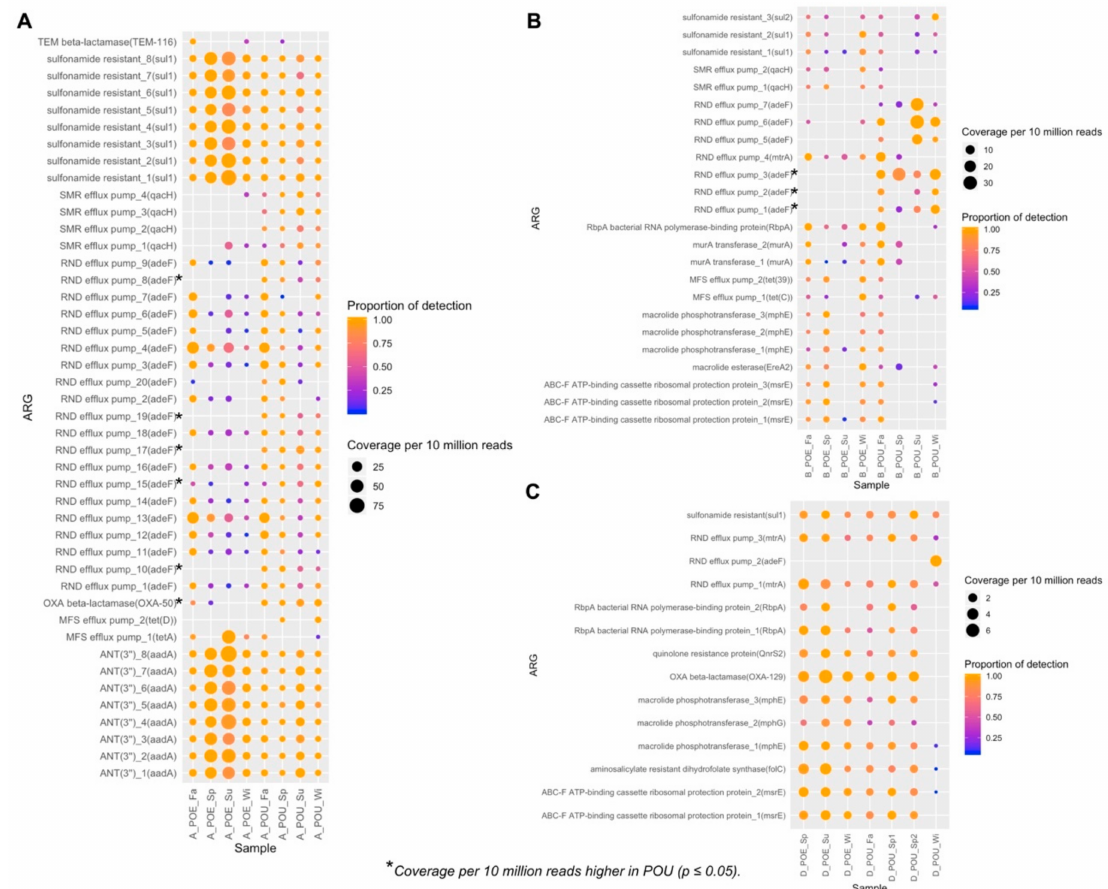
Figure 4. Coverage and proportion of detection for ARGs across samples in ( A ) site A, ( B ) site B and ( C ) site D. Coverage (relative abundance) of metagenome-resolved ARG were computed through mean coverage Q2Q3 and larger circle indicated a higher coverage. Proportion of detection indicated the fraction of coverage, and bigger proportion of detection meant more complete detection of the ARG in that particular sample. Names of ARGs (row) are based on their antimicrobial resistance AMR gene family and their gene